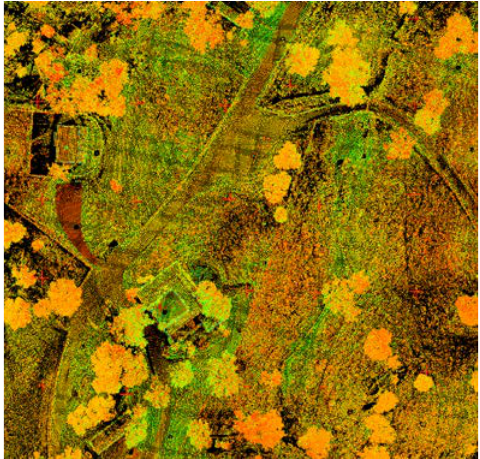
Figure 3: TLS point cloud from registered scan